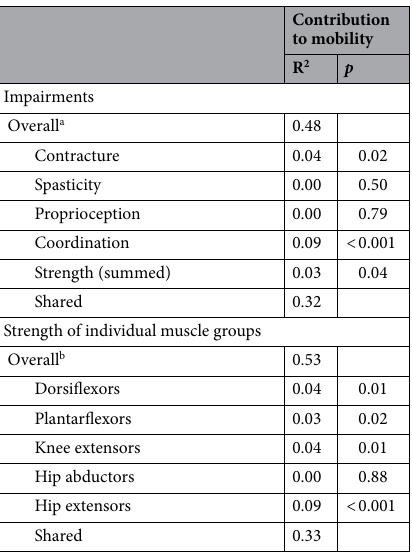
Table 4. Contribution of impairments and strength of individual muscle groups to mobility. a Five impairments overall account for 48% of the variance in mobility. b Five muscle groups overall account for 53% of the variance in